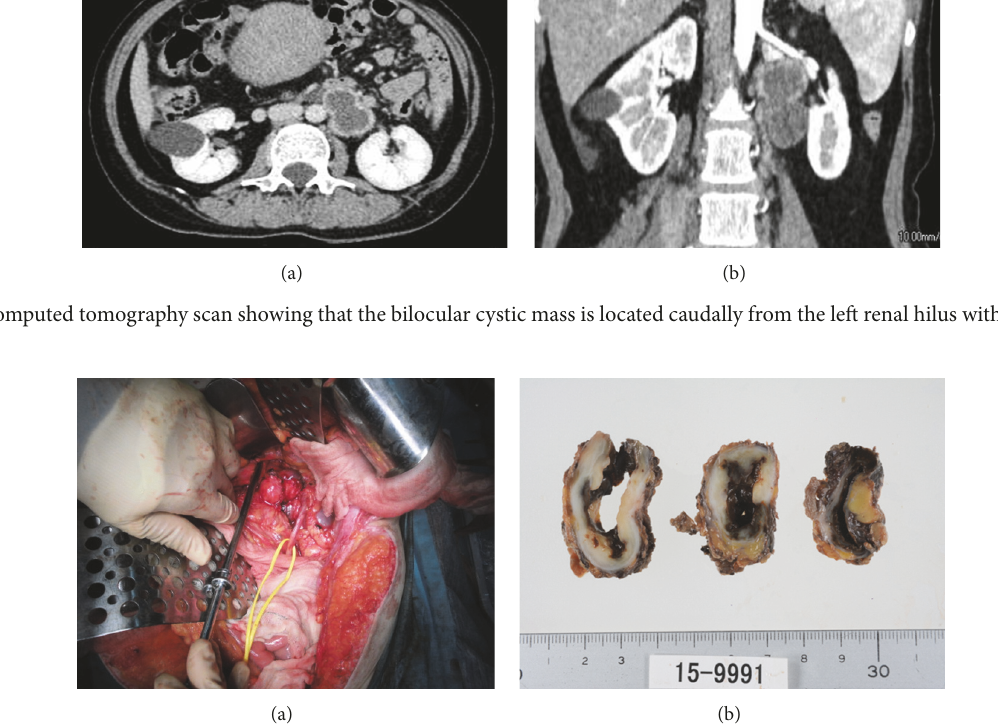
Figure 2: (a) Intraoperative findings showing that the peritoneal cyst in the left inferior kidney is bilocular, and it is firmly adhered to the left iliopsoas and ureter. (b) Photographs of the resected retroperitoneal cyst showing that it is bilocular with cystic space with old and new